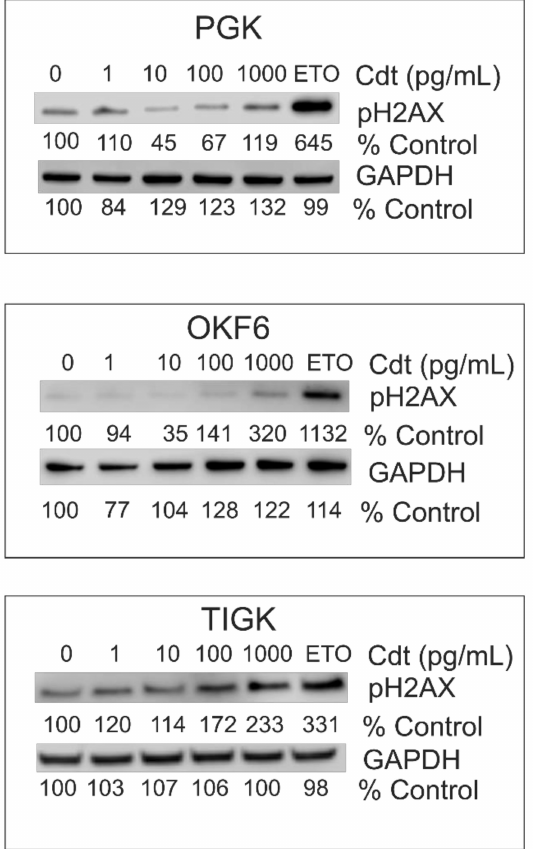
Figure 5. H2AX is not phosphorylated in oral keratinoyctes exposed to Aa Cdt. PGKs and immor- talized cell lines OKF6 and TIGK, were challenged with varying amounts of Cdt (doses required to induce cell cycle arrest as well as higher doses) or 25 µ M etoposide (ETO) for 4 h; cell lysates were assessed for pH2AX levels by Western blot. Results are representative of 3 experiments. Numbers indicate band intensity as a percentage of untreated cells. GAPDH is shown as a gel loading